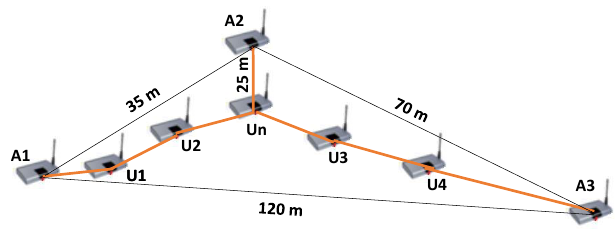
Figure 1. Wireless sensor network topology